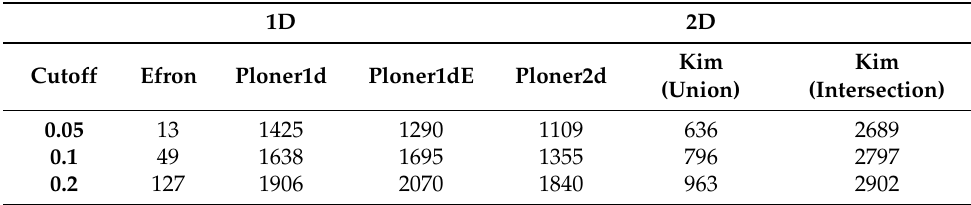
Table 7. Omija data: The number of rejection by each method.